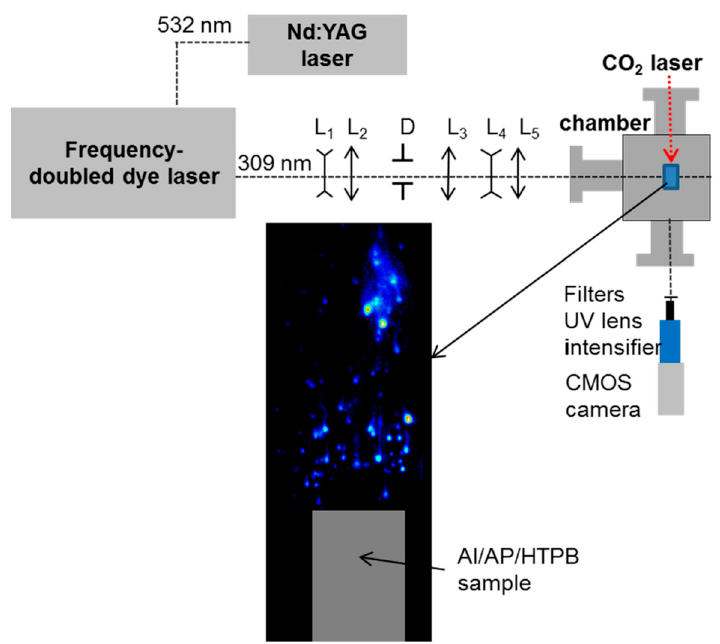
Figure 1. PLIF set-up and an example of laser-induced fluorescence imaging of aluminum atoms (Al-PLIF) image. The solid-propellant sample is displayed as a gray rectangle to suggest its location in the image. L: lenses for sheet formation. D: Diaphragm.